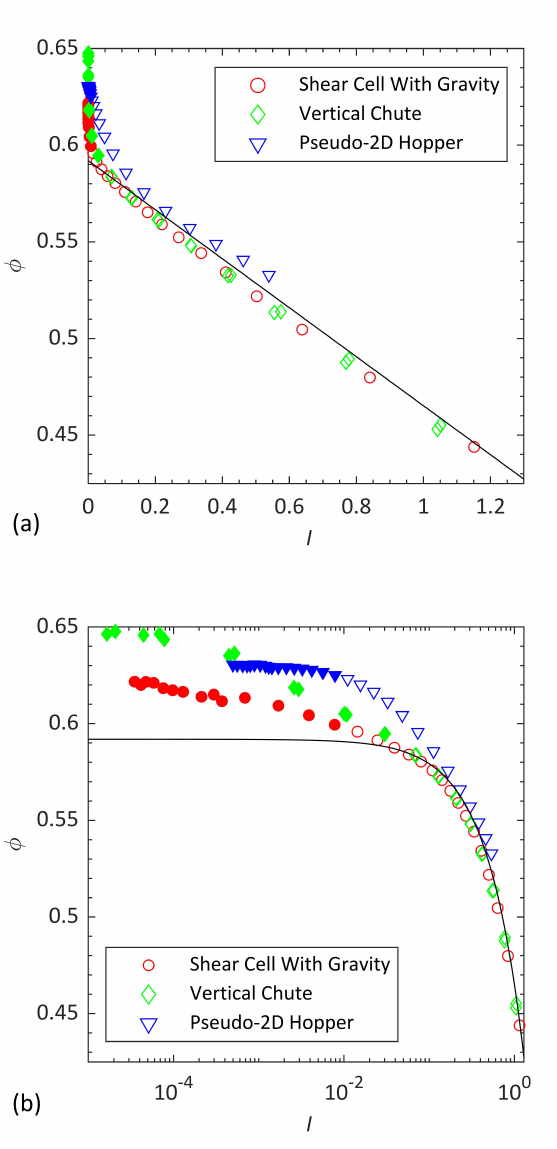
Figure 4. µ vs I plotted for a series of shear cells, a shear cell with gravity, a vertical chute and a pseudo-2D hopper. The filled markers denote positions were µ < µ s . The line is Equation 3 as fit to the shear cell